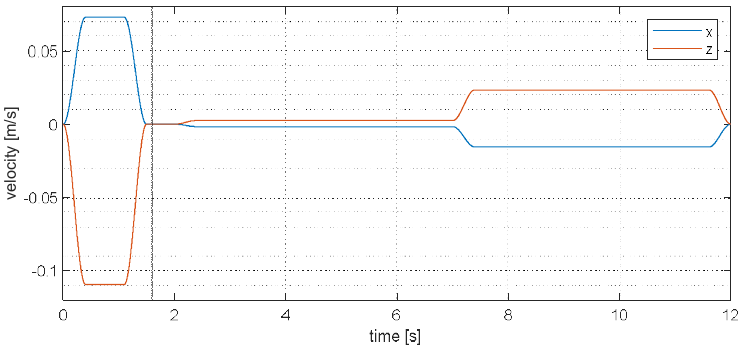
Figure 21. Desired end-effector velocities for the load picking task. The vertical gray line indicates the start time of contact.